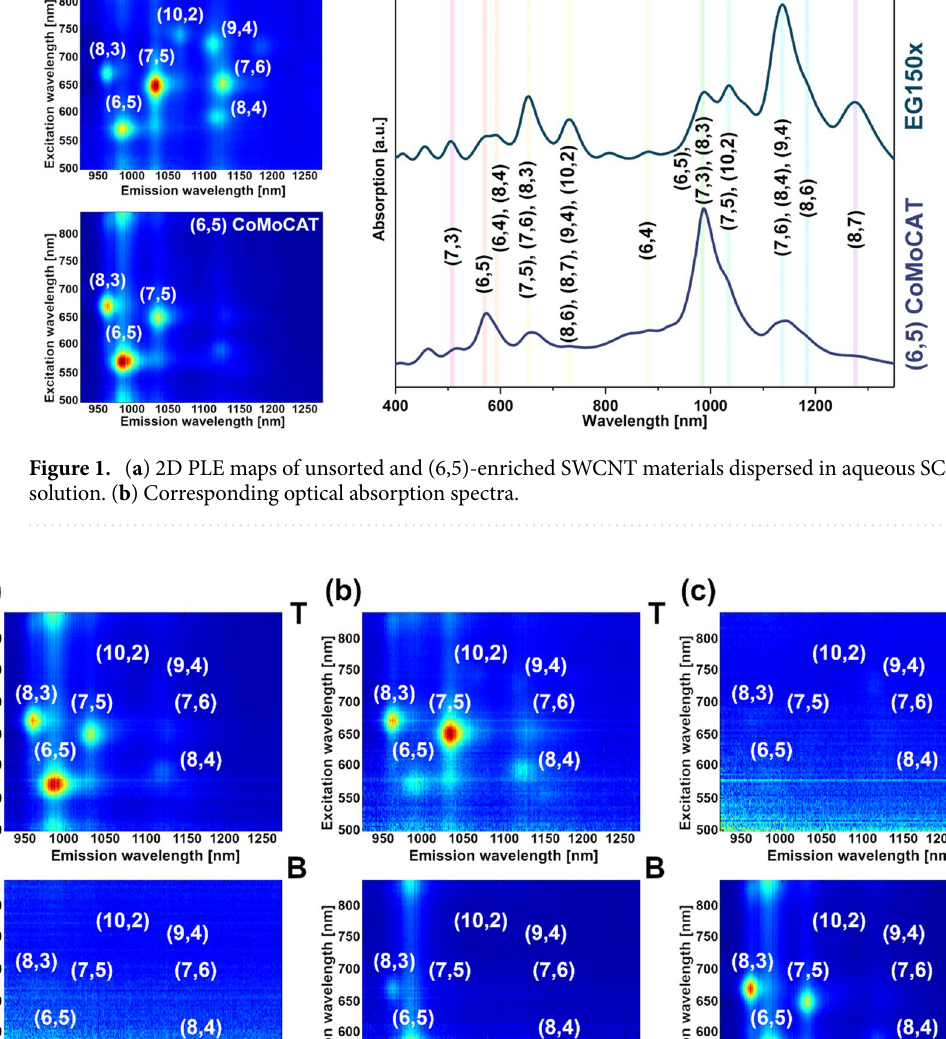
top phase composed of PEG to more hydrophilic bottom phase made of dextran (Fig. 2) 42 .